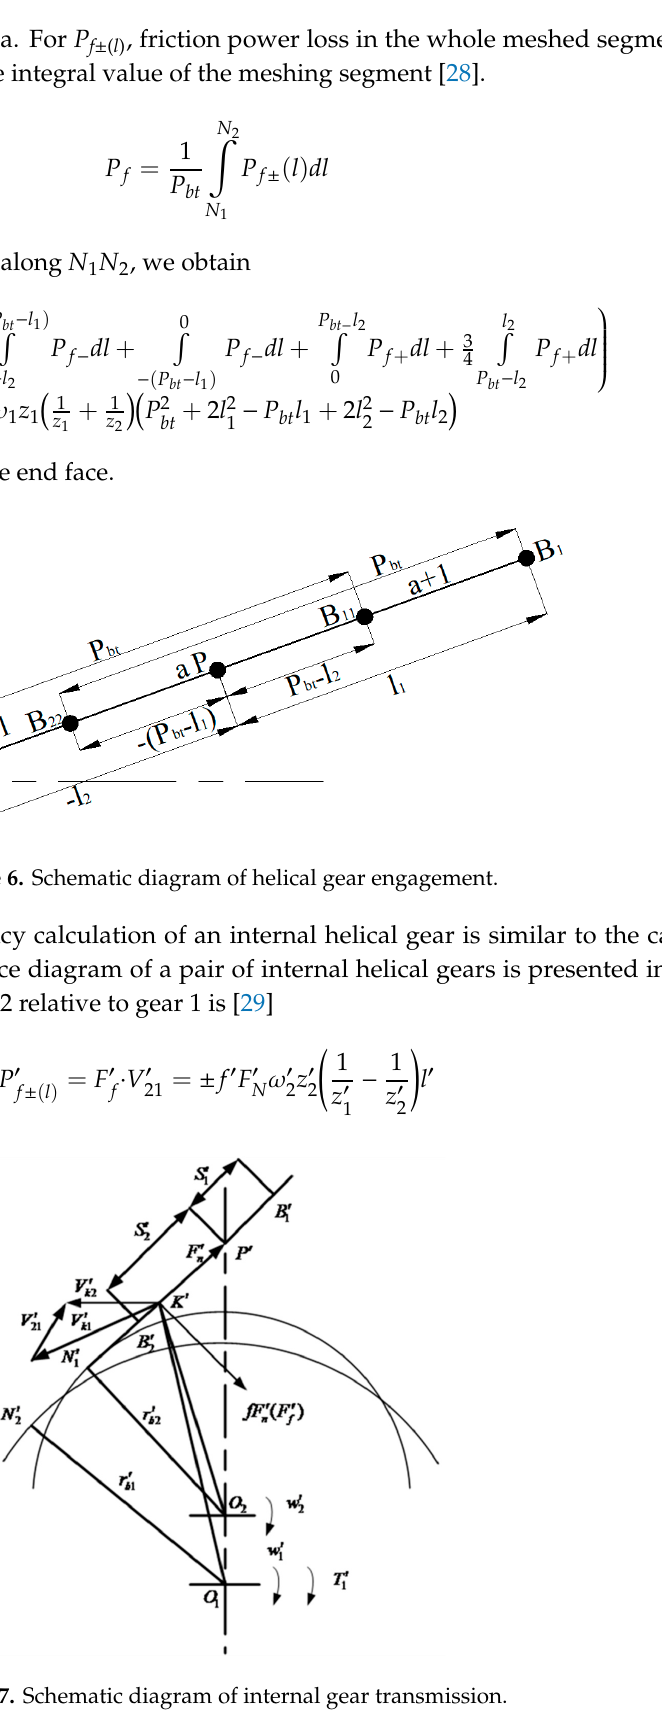
Figure 7. Schematic diagram of internal gear transmission.